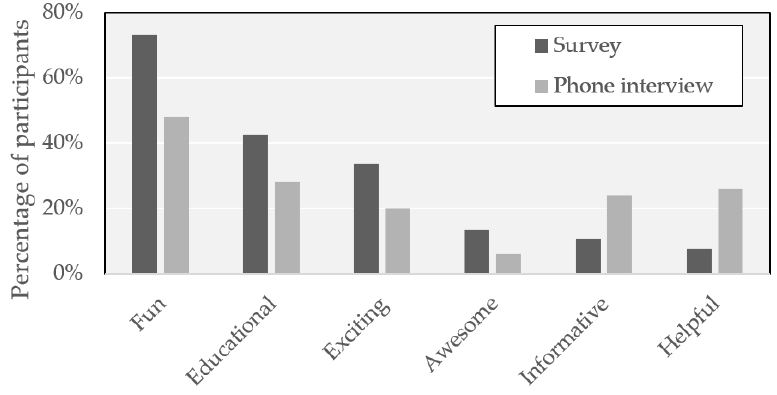
Figure 7. Key words: survey vs. phone interview.